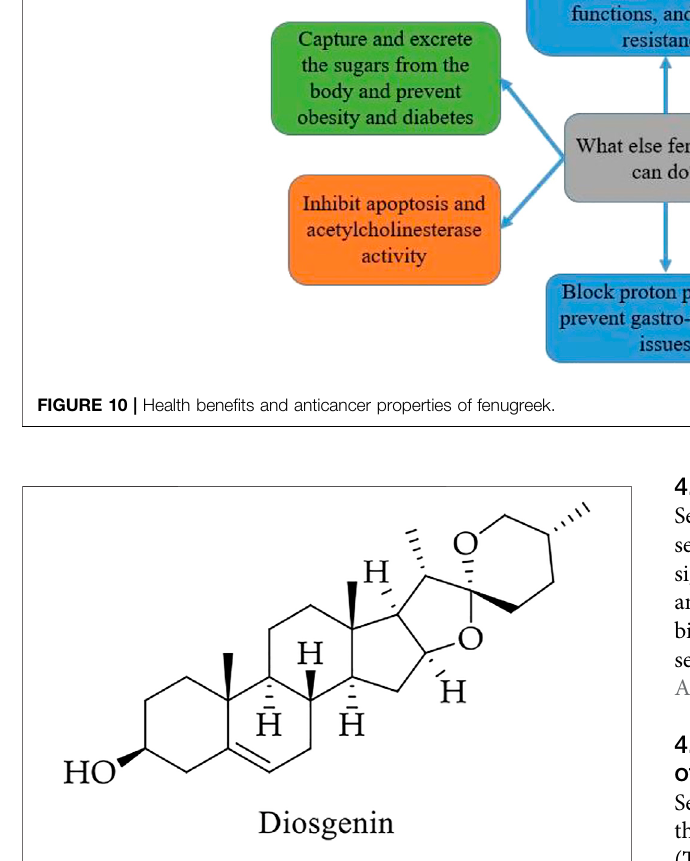
Frontiers in Pharmacology |